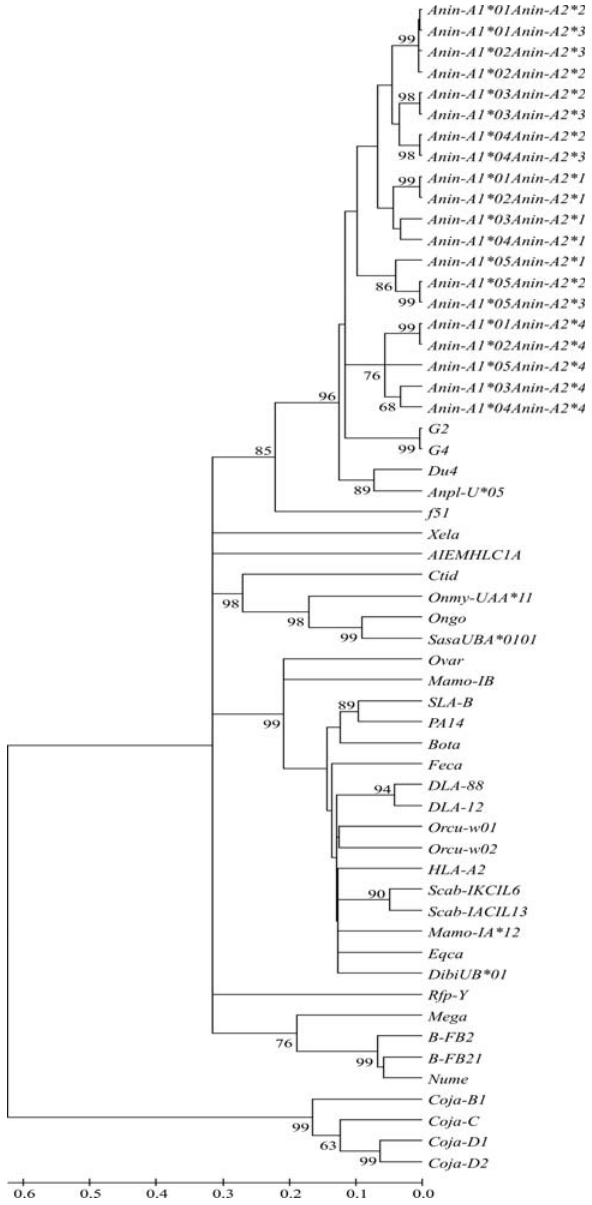
Figure 2 - Phylogenetic tree created by the NJ method based on the amino acid sequences of bar-headed goose MHC class I (cid:2) 1 and (cid:2) 2 domains and other vertebrates. Only bootstrap levels exceeding 60% are shown (as a per- centage) and are based on 1,000 replications. The sequence sources are as follow: goose ( G2, AY387649; G4 , AY387651), duck ( Du4 , AB115244; Anpl-U*05 , AY294419), human ( HLA-A2 , K02883), rainbow trout ( Onmy-UAA*11 , AB012064), chicken ( B-FB2 , AF013492; Rfp-Y , AF218783; B-FB21, AF013493), turkey ( Mega , DQ993255), helmeted guineafowl ( Nume , EF643463), grass carp ( Ctid , AB109779), African clawed frog ( Xela , L20733), dog ( DLA-88 , U55028; DLA-12 , U55026), pig ( SLA-B , AY135599; PA14 , AF014001), Ameiva ameiva ( AIEMHLC1A , M81094), pink salmon ( Ongo , D58386), Atlantic salmon (SasaUBA*0101 , AF504019), horse ( Eqca , X71809), domestic cat ( Feca , U07674), Diceros bicornis minor ( DibiUB*01 , AF055347), sheep ( Ovar , M34676), cattle ( Bota , Y09208), rabbit ( Orcu-w01 , K02442; Orcu-w02 , K02441), wood- chuck ( Mamo-IA*12 , AF146092; Mamo-IB , AF201912), tassel-eared squirrel ( Scab-IKCIL6 , M97618; Scab-IACIL13 , M97617), Japanese quail ( Coja-C , BAA83671; Coja-D1 , BAC82515; Coja-D2 , BAC82516; Coja-B1 , BAC82519), Florida sandhill crane (f51,